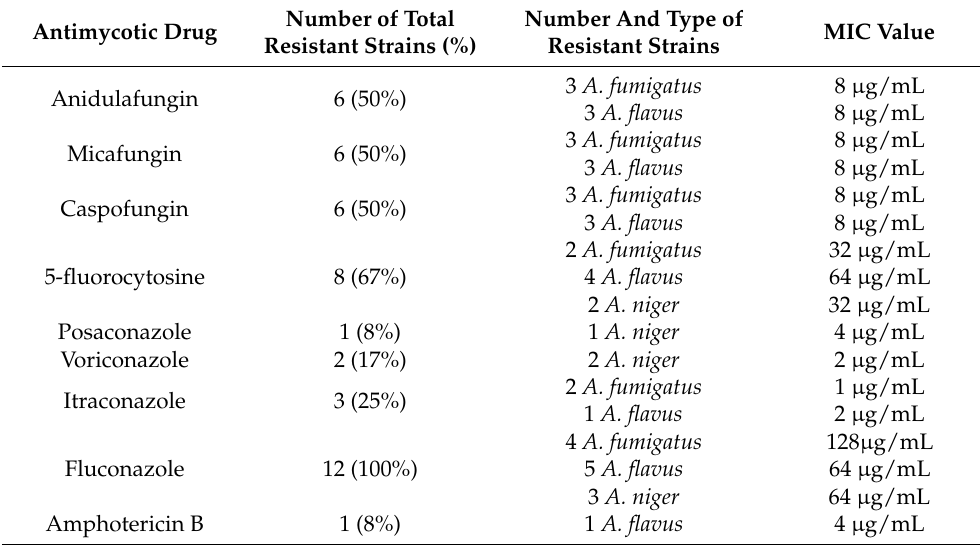
Table 5. Results of antifungal susceptibility